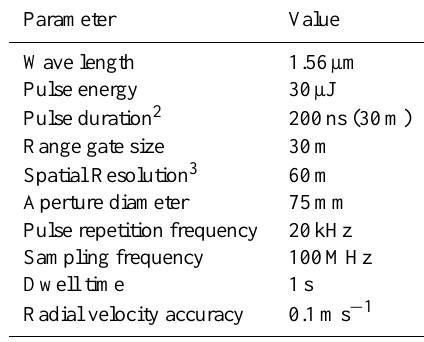
Table 1. Galion G4000 Doppler wind lidar specification 1